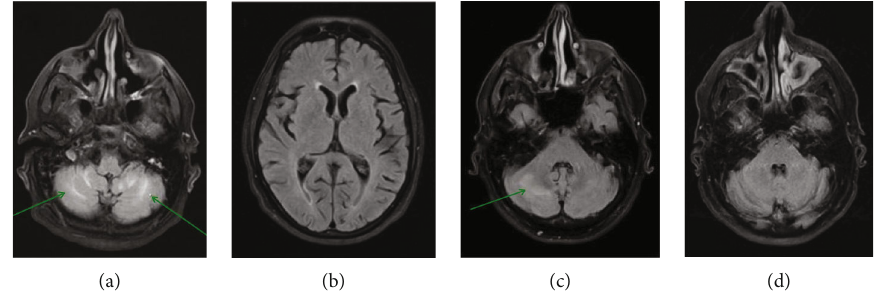
Figure 2: T2-FLAIR Magnetic Resonance Imaging (MRI) brain with contrast demonstrating (a) symmetric T2-hyperintensity of the cerebellum on initial case presentation, (b) representative image demonstrating lack of cerebral involvement during initial case presentation, (c) subsequent 2-week follow-up MRI demonstrating resolving T2-hyperintensity in the cerebellum, and (d) complete resolution of cerebellar T2-hyperintensity 6 months